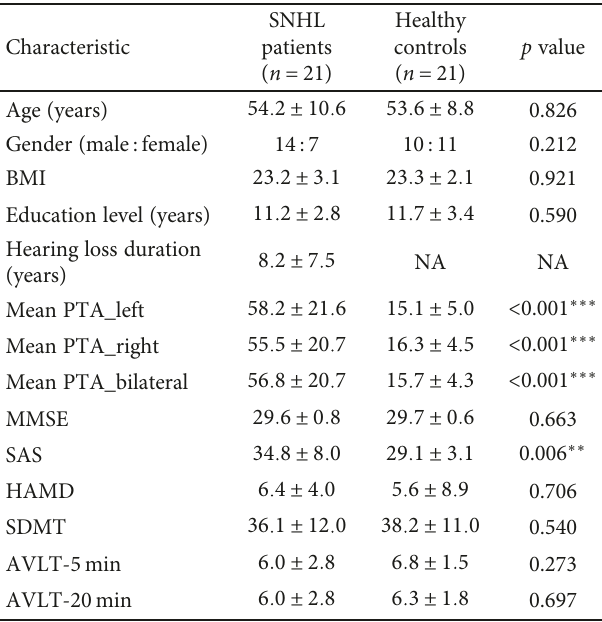
Table 1: Characteristics of long-term bilateral sensorineural hearing loss patients and healthy